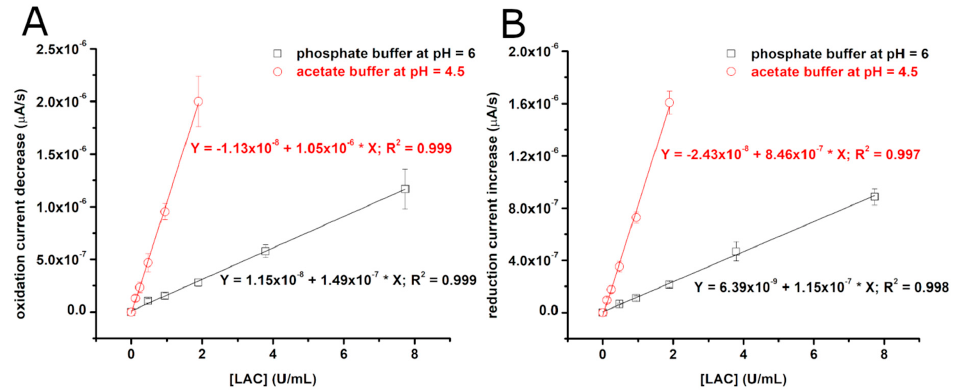
Figure 2. Average calibration curves for the determination of laccase activity. The curves were obtained with three different CFMEs in two different buffers using cyclic voltammetry currents at either +0.4 V (where the current is proportional with the concentration of reduced ABTS) ( A ) or 0 V (where the current is proportional with the concentration of oxidized ABTS) ( B ). The ABTS concentration was always 0.5 mM. It is important to note that currents at + 0.4 V decrease when laccase is present, whereas currents at 0 V increase when laccase is